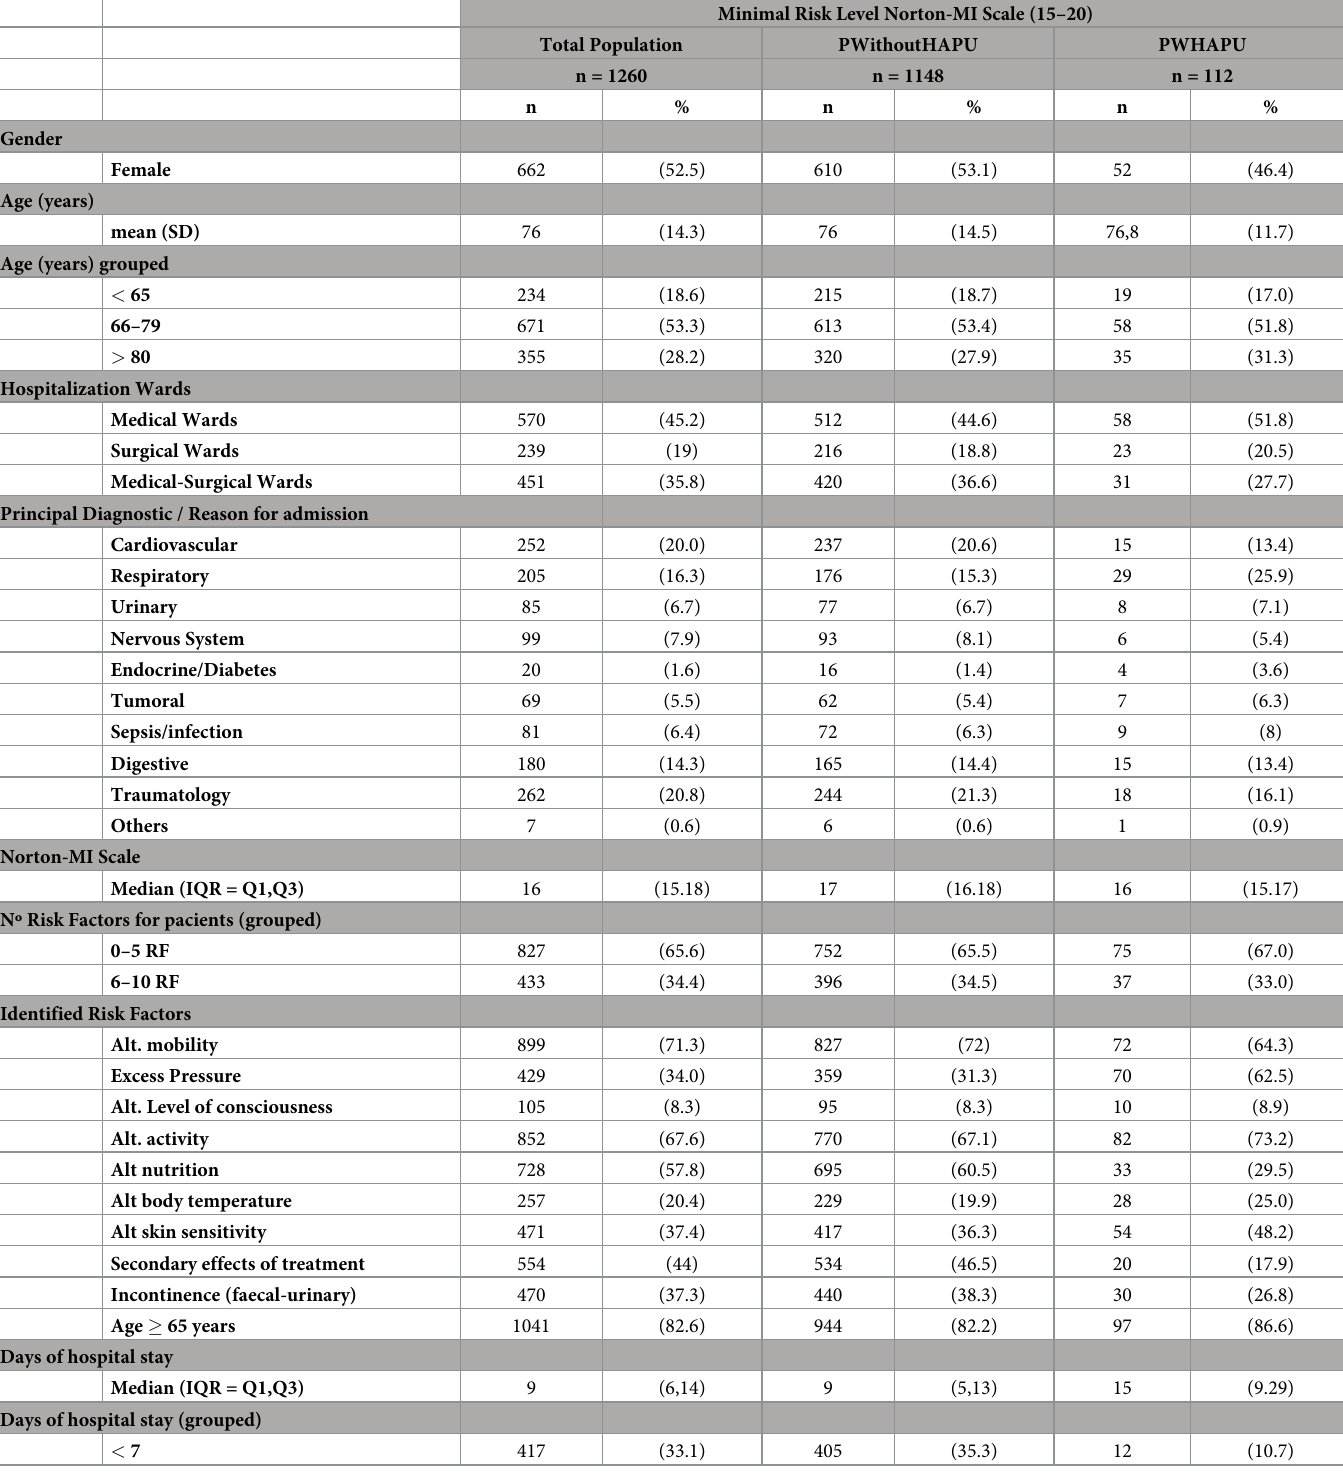
Table 1. Description of the characteristics of the population classified as "minimal risk", patient with HAPU (PWHAPU) and patient without HAPU